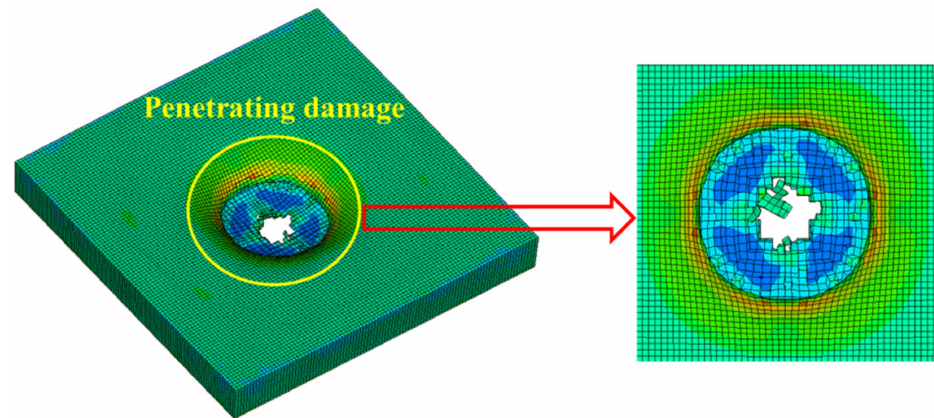
Figure 21. Failure states of polyurethane sacrificial cladding in the CEL model.